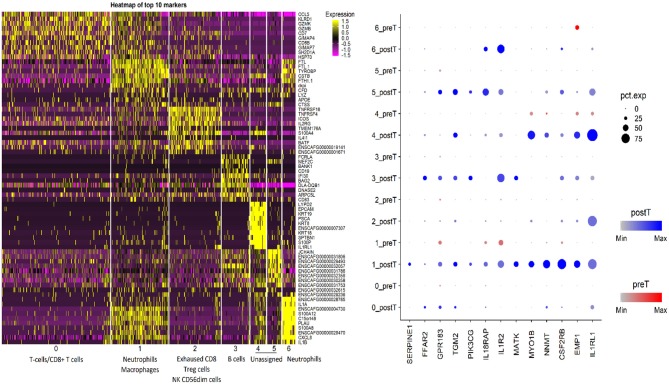
Single cell RNA-seq analysis of canine invasive urothelial carcinoma. Unsupervised clustering of the canine InvUC sample was performed (Seurat package, Satija Lab). The cells segregated into seven different clusters. Putative cell type assignment was based on marker gene expression and abundance within the cluster. The gene expression heatmap focused on the CD45+ cells (immune cells) shows the cell clusters with putative immune cell type assignments on x-axis and top 10 marker genes in each cluster on Y-axis. The split dotplot on right shows the intensity (dot color) and percentage of cells expressing (dot size) 13 marker genes (x axis) analyzed in InvUC tissue across clusters before and after treatment (y axis). This type of data can be used to study mechanisms and generate new hypotheses. For example, GPR183 which increases in cluster 1 cells, is known for its role in lymphoid organ development and positioning of activated CD4 T cells in lymphoid follicles, but its role in the immune state of InvUC has not been elucidated (174).